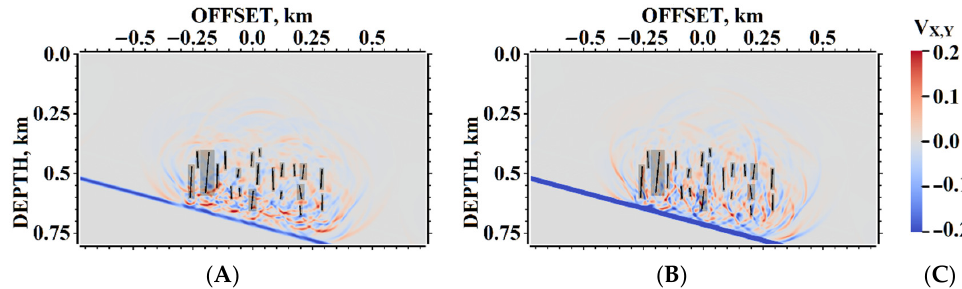
Figure 22. Example #1, incident P-wave, snapshots at the time moment 0.26 s: ( A ) horizontal component of velocity; ( B ) vertical component of velocity; ( C ) scale of the velocity components used in the paper.